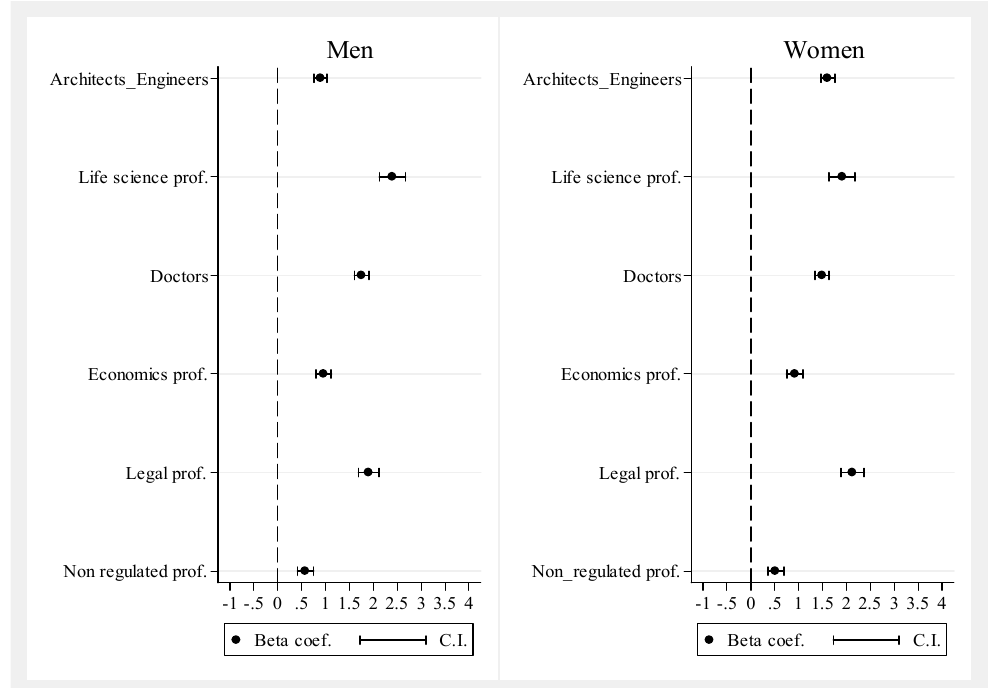
Figure 1. Micro-class parameters for social immobility in the higher service class across gender. Beta coefficients with confidence intervals extrapolated from Model 3b.